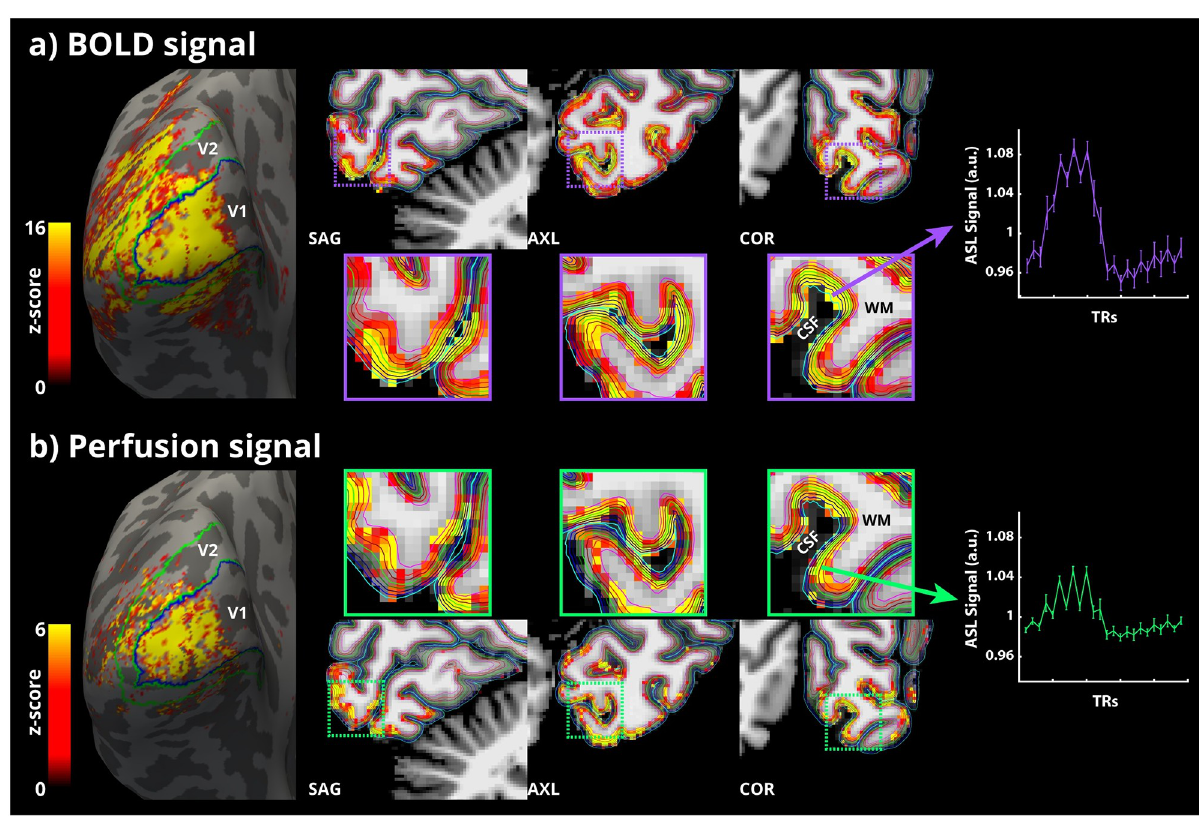
Fig 2. (a, left-right) BOLD signal activation map of an example participant, averaged over all runs, overlaid on the inflated left hemisphere reconstruction from Freesurfer. Contours of the V1 (blue) and V2 (green) labels obtained from Neuropythy are also overlaid on the inflated surface. Cropped orthogonal views of the participant’s occipital lobe with the BOLD signal activation map overlaid in voxel space. Boundaries of the different laminar surfaces are also overlaid, colour-coded from cyan (pial)-to-magenta (white). The purple dotted square inset indicates the zoomed-out views presented below. Event-related average ASL time-course of highly BOLD activated voxels across runs for this participant is shown to the right. (b, left- right) The same are presented for perfusion activation in green. The error-bars indicate SEM across trials.